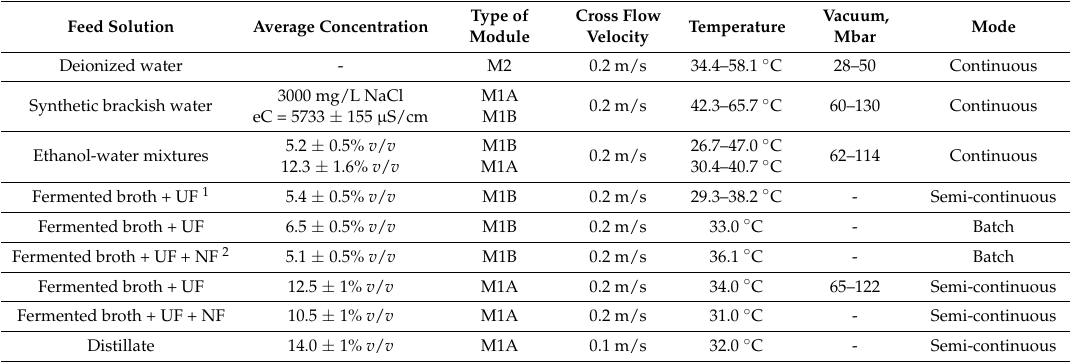
Table 1. Types of feed solutions and experimental